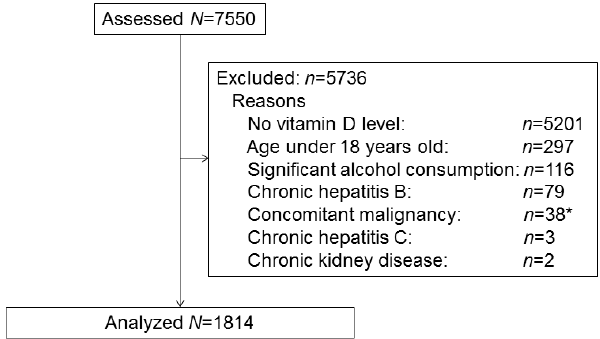
Figure 1. Flow diagram of subjects included in the cross-sectional study. * Thyroid cancer: n = 17; stomach cancer: n = 10; cervical cancer: n = 2; head and neck cancer: n = 2; bladder cancer: n = 2; breast cancer: n = 1; lung cancer: n = 1; rectal cancer: n = 1; endometrial cancer: n = 1; lymphoma: n = 1.